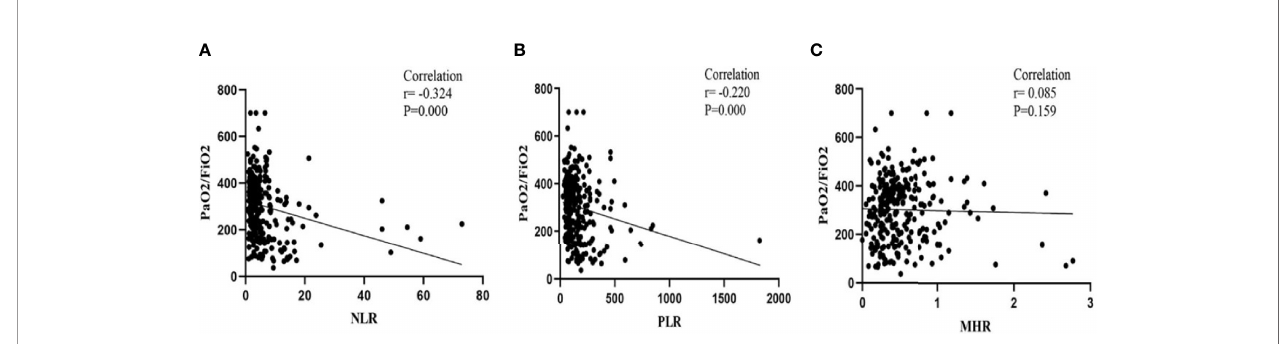
FIGURE 1 | Correlations of the NLR, PLR and MHR with PaO2/FiO2 on admission: (A) Correlations of the NLR with PaO2/FiO2; (B) Correlations of the PLR with PaO2/FiO2; (C) Correlations of the MHR with